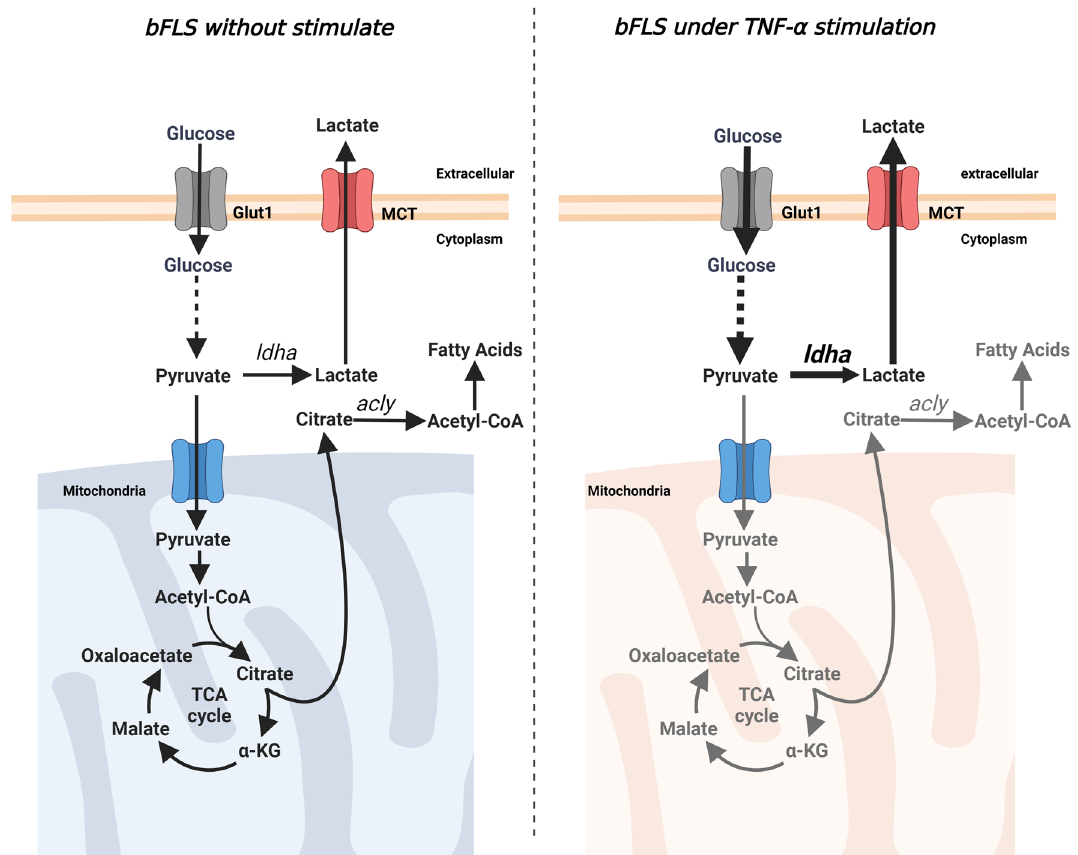
lactate extracellular concentration via monocarboxylate transporters (MCT). In addition, bTNF-α reduces fatty acid synthesis via citrate/acetyl-CoA. acly : ATP-dependent citrate lyase Created with